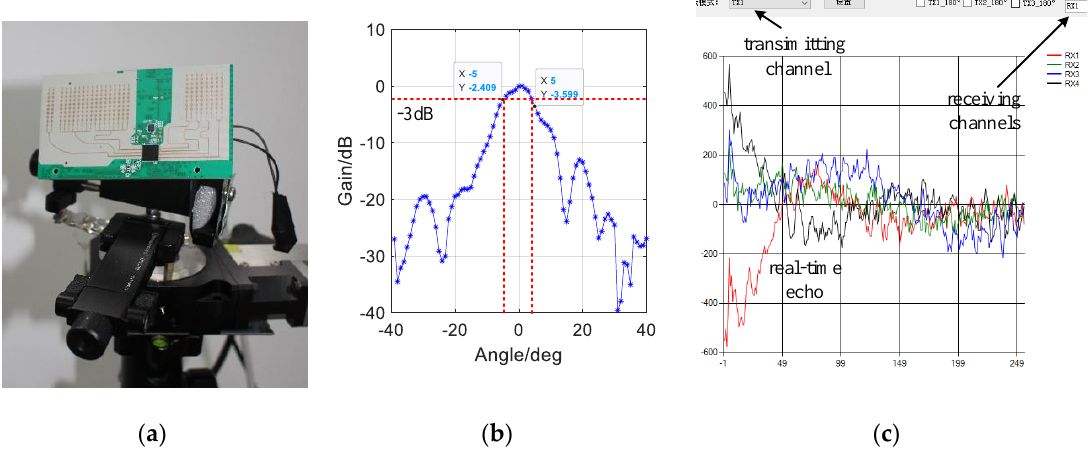
Figure 6. Some details of the radar system: ( a ) The planar folded reflect-array antenna; ( b ) The measured beam pattern in horizon, with 3 dB aperture of 10 deg; ( c ) The real-time data when selecting the first transmitting channel, preliminarily processed by the analyzing software. Table 2. Specifications of the 78.5 GHz